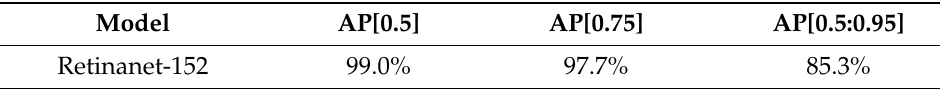
Figure 6. Entire prediction process including the detection of the mandibular third molar, classifica- tion of extraction difficulty, and likelihood of IAN injury. Table 1. Mandibular third molar detection